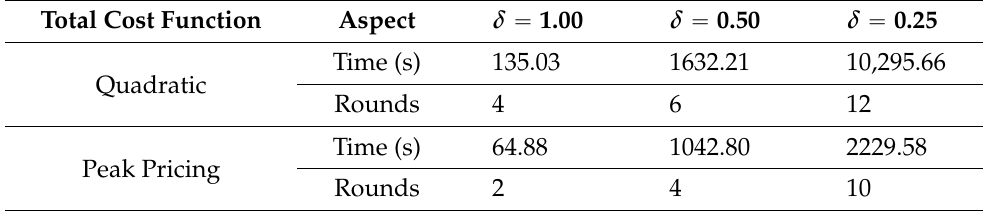
Table 6. BRD solution times when changing the size of the time slot (all cases with N =